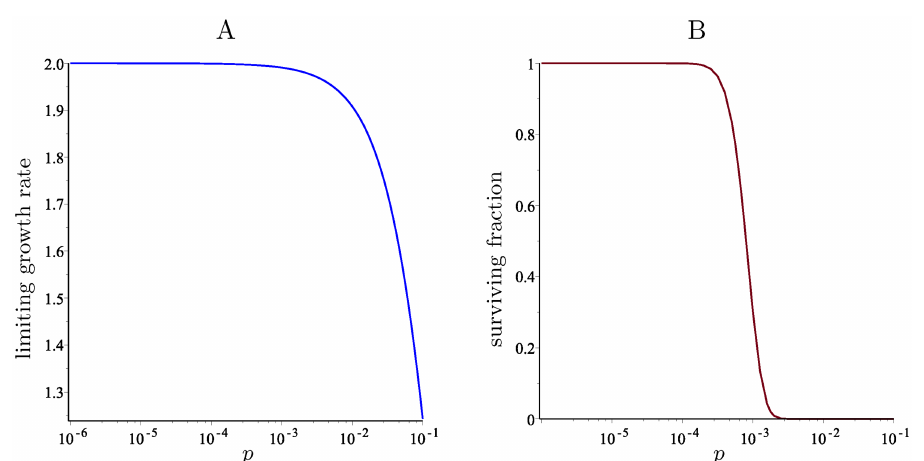
Fig 2. The limiting growth rate and surviving fraction in the basic model with N = 8. A: The limiting growth rate as a function of p (in a logarithmic scale). B: The fraction of cells that survive after 1000 generations, starting with a founder cell with 4 copies of each